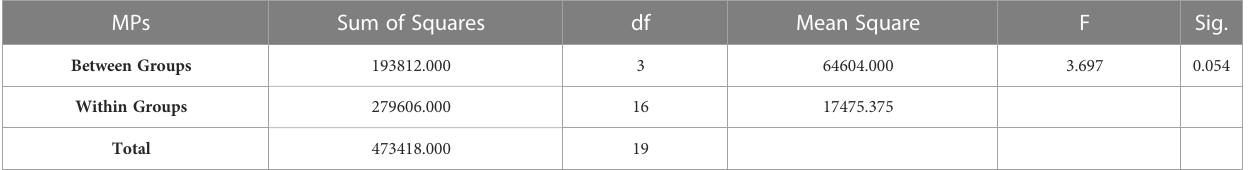
FIGURE 3 Average MP abundance and MP composition in coastal bottom sediment of each study